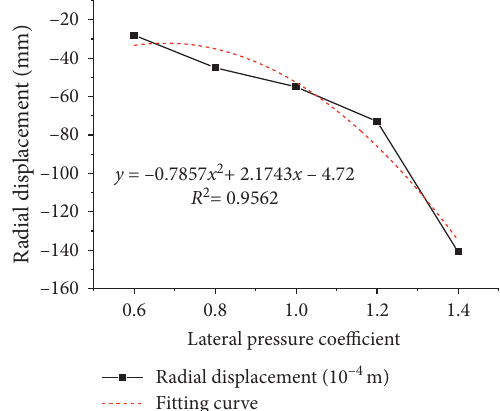
Figure 6: Dynamic diagram of the radial position of number 1 measuring point in the middle of the shaft wall ( z � 11m from the bottom).